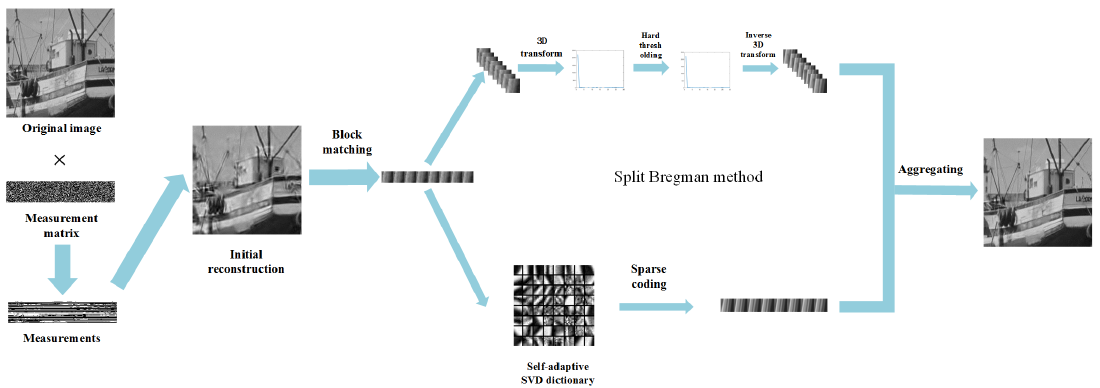
Figure 2. Flowchart of the proposed